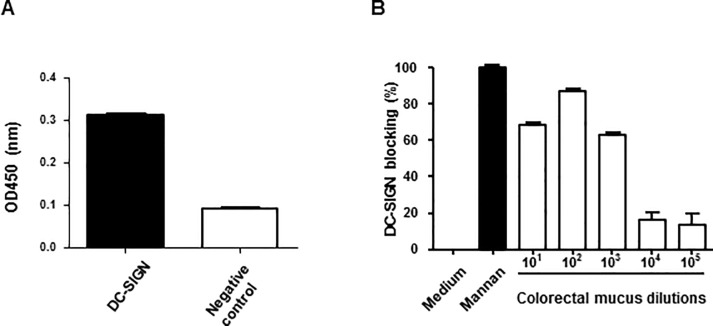
CM binds DC-SIGN thereby preventing gp140 binding.(A) DC-SIGN binding ELISA with 300 fold diluted CM coated on an ELISA plate and DC-SIGN-Fc as detection antibody, demonstrates DC-SIGN-Fc binds CM compared to EGTA treated product (negative control) (p<0.0001). (B) DC-SIGN-Fc was pre-incubated with mannan (positive control) and CM dilutions before being added to a gp140 coated plate. Depicted is the percentage by which DC-SIGN-Fc binding to gp140 is blocked, pre-incubation with mannan was set to 100% blocking and pre-incubation with medium to 0%. Pre-incubating DC-SIGN-Fc with up to a 1000 fold diluted CM inhibits HIV-1 envelope gp140 trimer binding. Data points were performed in triplicate.